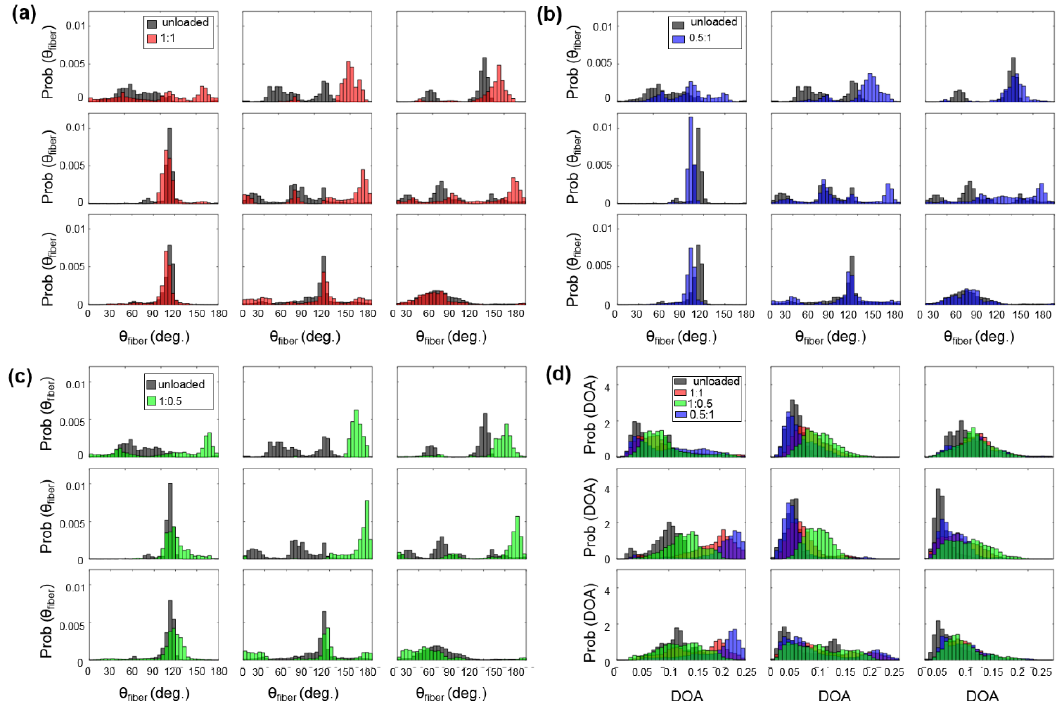
Figure A3. 3 × 3 grid comparisons of the predicted θ 𝑓𝑖𝑏𝑒𝑟 : ( a ) between unloaded and equibiaxial loading, ( b ) between unloaded and radially-dominate loading, and ( c ) between unloaded and circumferentially-dominate loading. ( d ) Comparison of the predicted DOA among all the states for the TVPL specimen of heart #1.